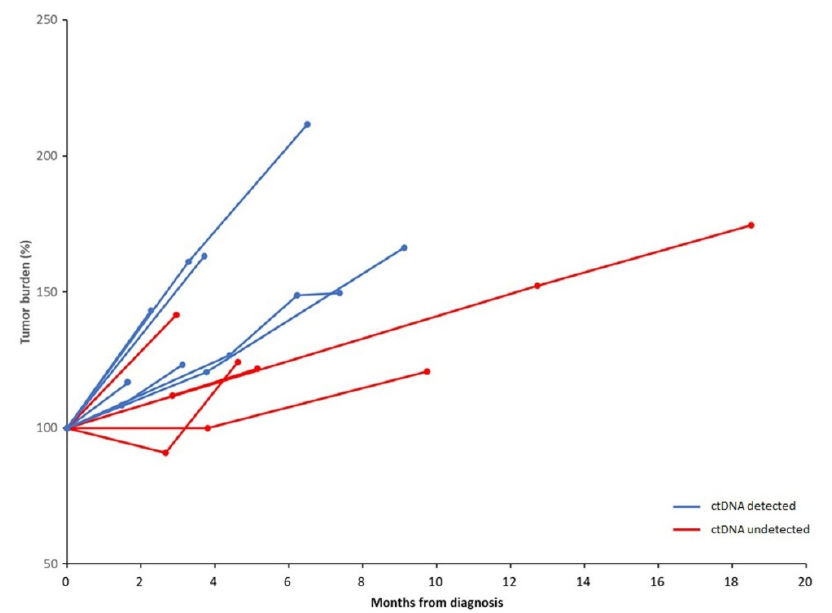
Figure 2. Changes in circulating tumor DNA (ctDNA) level of mutated gene in longitudinal plasma samples for patients with detected ctDNA. Each circle indicates a time point for plasma sampling and imaging test. In P3, the size of the primary tumor slightly increased whereas the area with tumor necrosis decreased at the second follow-up period (black arrow). In P12, pneumonia accompanied at diagnosis and the third follow-up period (red arrow).